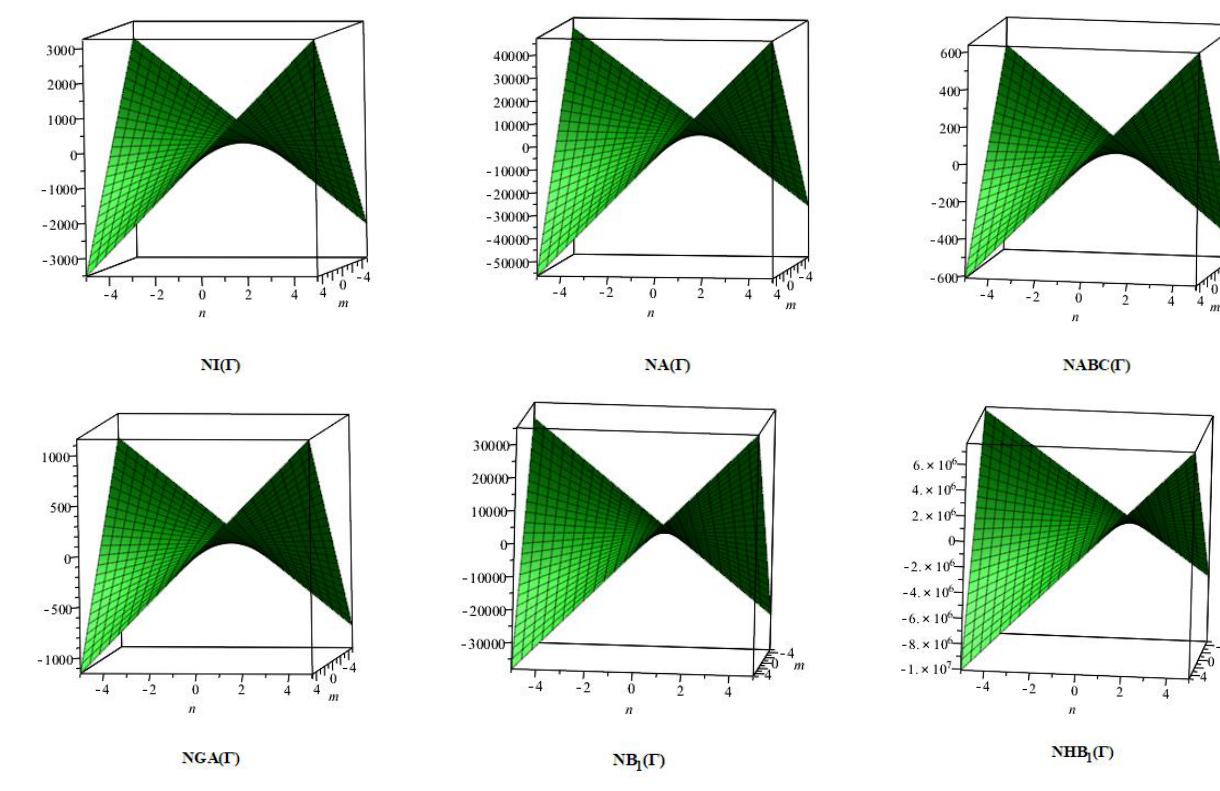
Figure 8. 3D plots for theorem 5.